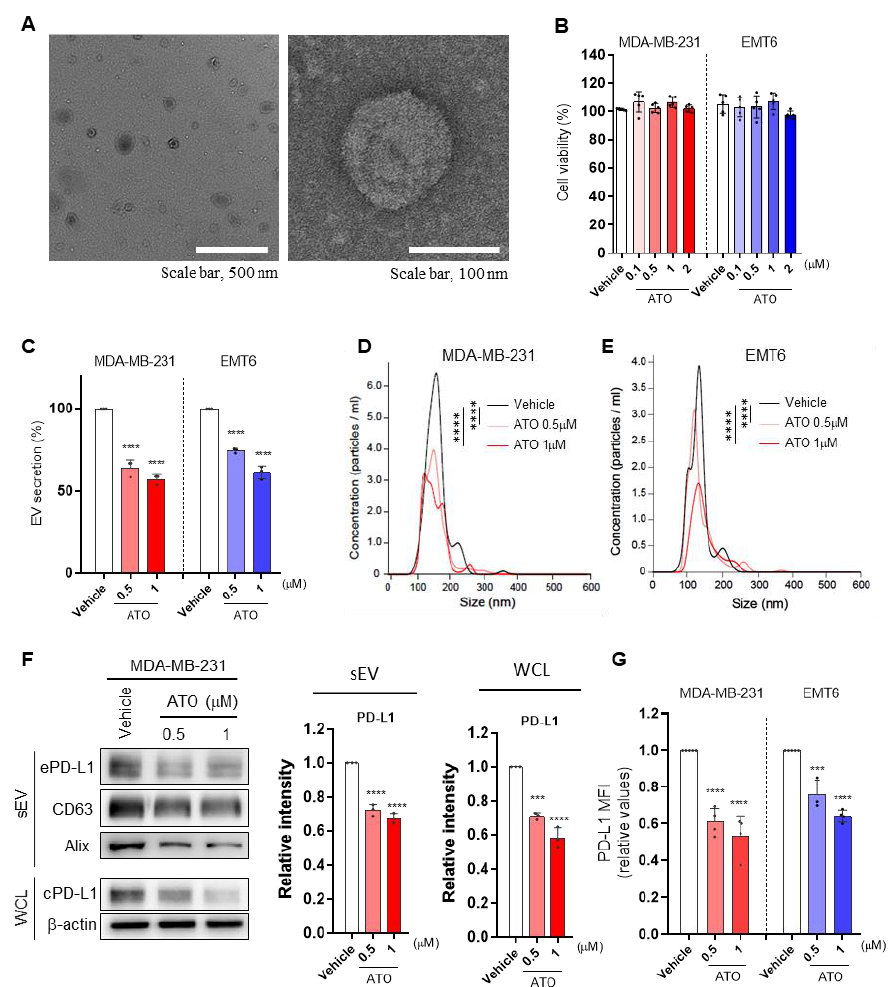
Figure 1. Atorvastatin (ATO) suppresses the secretion of EV PD-L1 by inhibiting EV secretion and PD-L1 expression. ( A ) Transmission electron microscopy images of MDA-MB-231-derived EVs. The images at the left and right panels show EVs with low (scale bar, 500 nm) and high magnification (scale bar, 100 nm), respectively. ( B ) Measurement of cancer cell viability by MTT assay. MDA-MB-231 and EMT6 cells were treated with different concentrations of ATO ( n = 5). ( C ) Measurement of secreted EVs by MDA-MB-231 and EMT6 cells using nanoparticle tracking analysis (NTA). Quantification of secreted EVs in the presence of different ATO concentrations ( n = 3). Size distribution of secreted EVs from ( D ) MDA-MB-231 and ( E ) EMT6 cells with or without ATO treatment assessed using NTA. ( F ) Immunoblot of various proteins in EVs and whole-cell lysates from MDA-MB-231 cells with or without ATO treatment ( n = 3). ( G ) Fold change of mean fluorescence intensity (MFI) of PD-L1 levels. The results are presented as means ± S.D. of three independent experiments. *** p < 0.001, and **** p < 0.0001; NS, not significant.